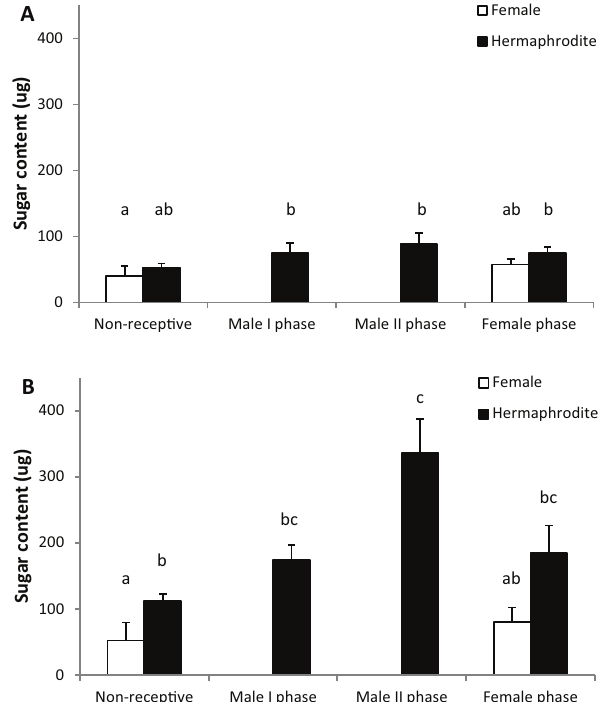
Figure 3. Sugar content in nectar standing crop and nectar accumulated in 24 hours. (A) Sugar content ( m g per flower) nectar standing crop and (B) nectar accumulated in 24 hours in female (white bars) and hermaphrodite (black bars) Geranium sylvaticum flowers across the different floral phases. Bars indicate mean + S.E. Different letters above the bars indicate statistically significant differences among groups at P , 0.05.